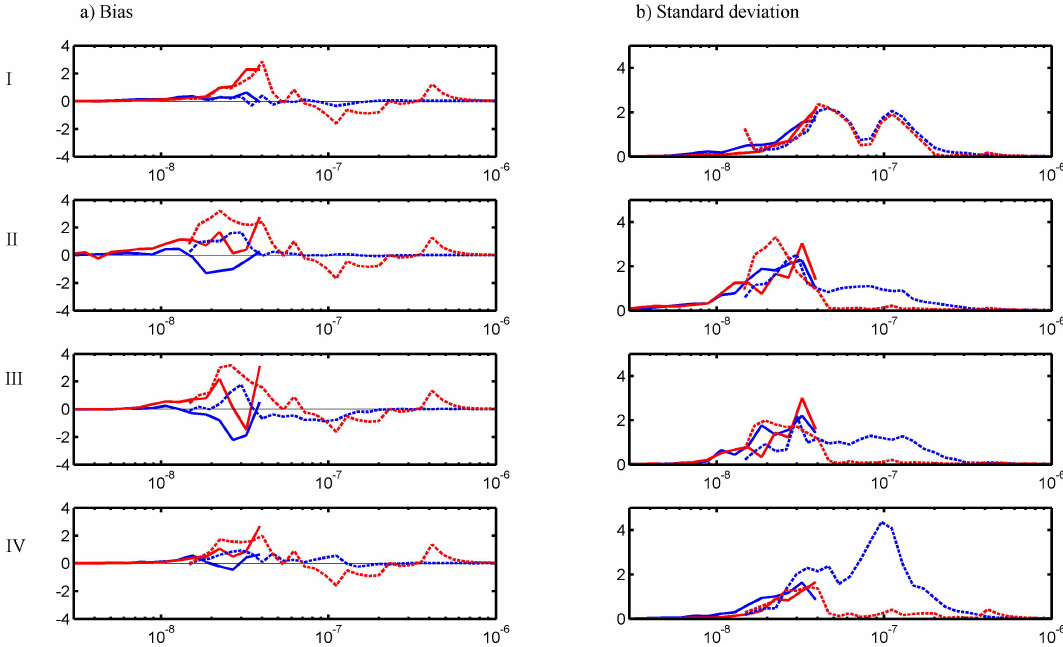
Fig. 4. The bias and standard deviation of x EKF (blue) and x INV (red) as compared to the raw measurements from DMPS I (solid) and II (dashes) for time windows I to IV. The bias and standard deviation are on the y-axis [cm − 3 ] and particle diameter on the x-axisis [m]. Note that the results are presented for the characteristic